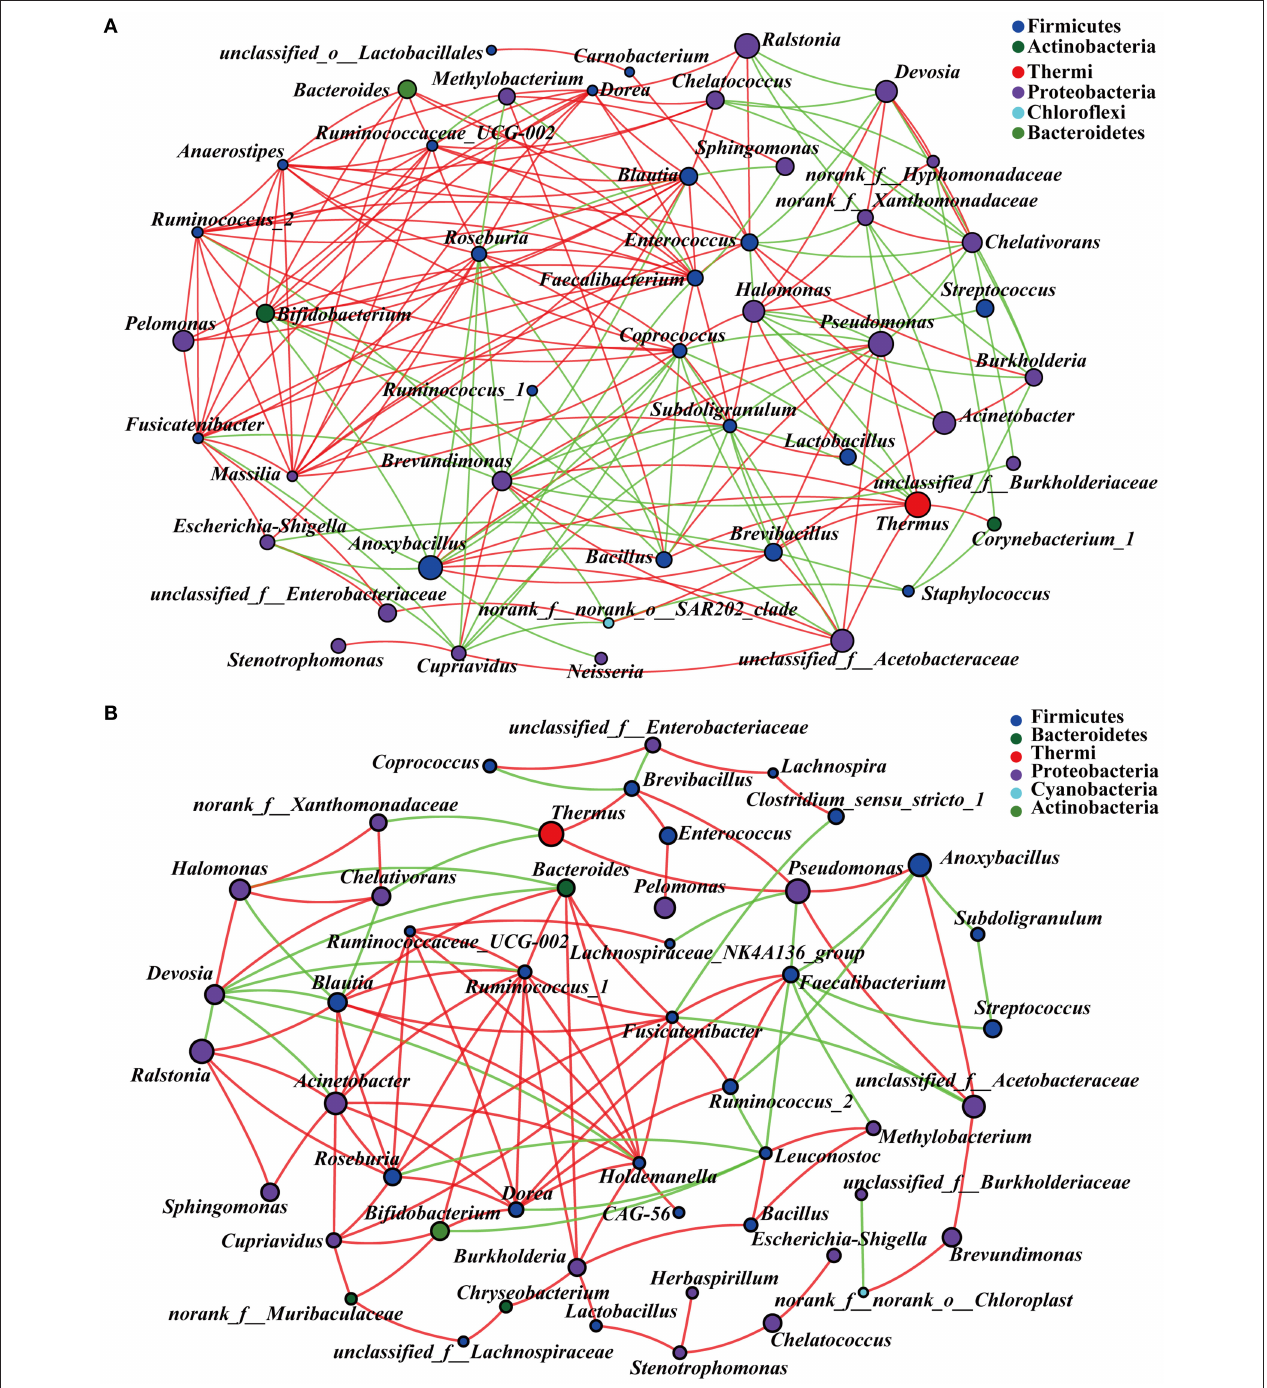
FIGURE 6 | Microbial communities co-occurrence network analysis across the embryonic late stage (the age of embryos 17–21). (A) Intestinal microbiota from control chick embryos; (B) Intestinal microbiota from injected with 7mg L -arginine group; The figure shows species with p < 0.05 based on the spearman’s correlation. The size of nodes indicates the relative abundance of the species. Red and green lines represent positive and negative correlations between two nodes, respectively.